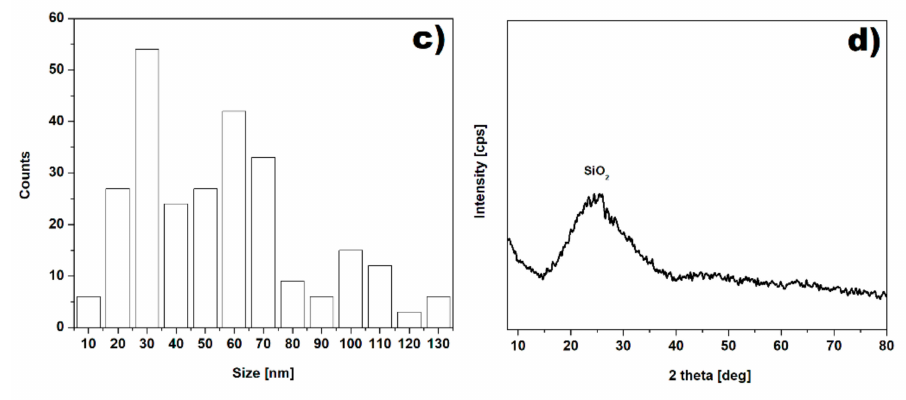
Figure 1. TEM images ( a , b ), size distribution ( c ), XRD ( d ) of nanosilica (NS). Reproduced from Sikora et al. 2020 [40].